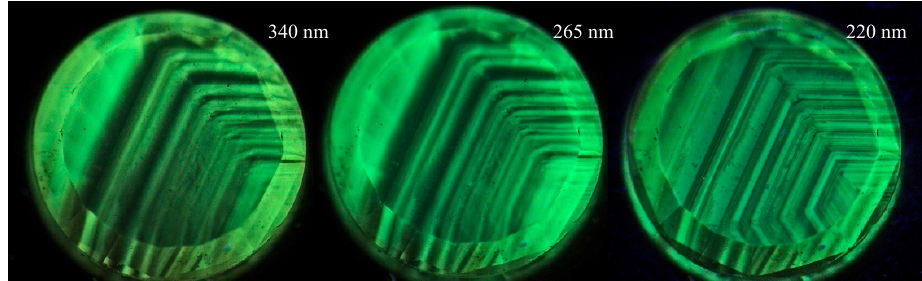
Figure 11. A brown “Pseudo CO 2 ” diamond (sample SGDF-5864) under three different UV excitations of the DFI system. The yellowish green to green PL is caused mainly by the S2 defect; the PL is much stronger in the colorless sectors than in the colored ones, the darkest brown sectors are practically inert.